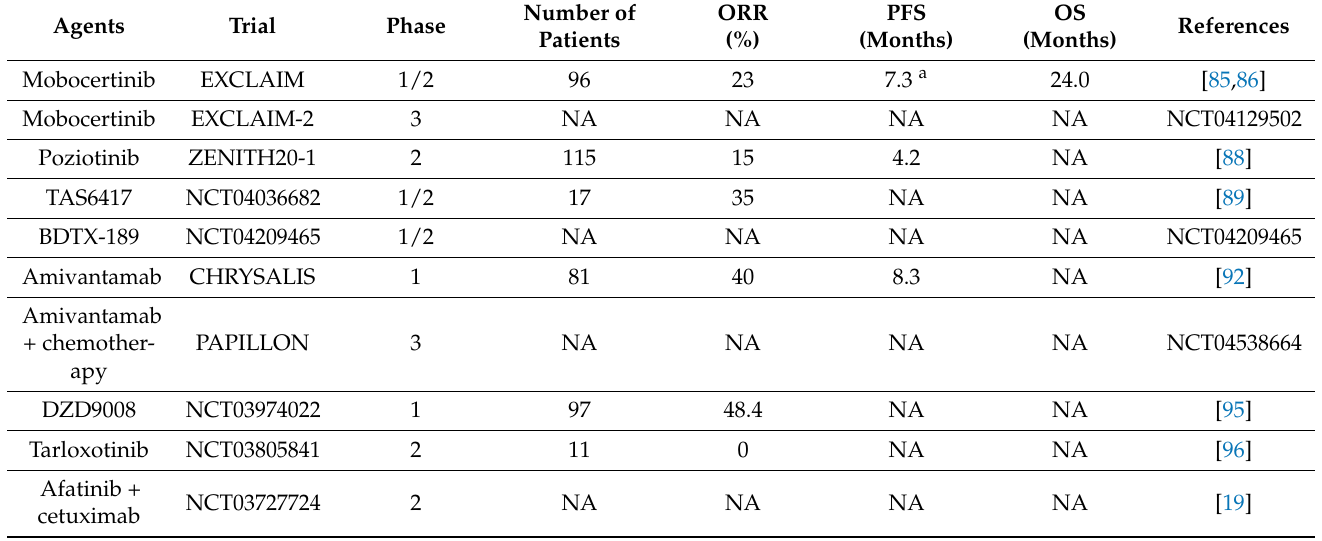
Table 2. Clinical trials of exon 20 insertion-targeted